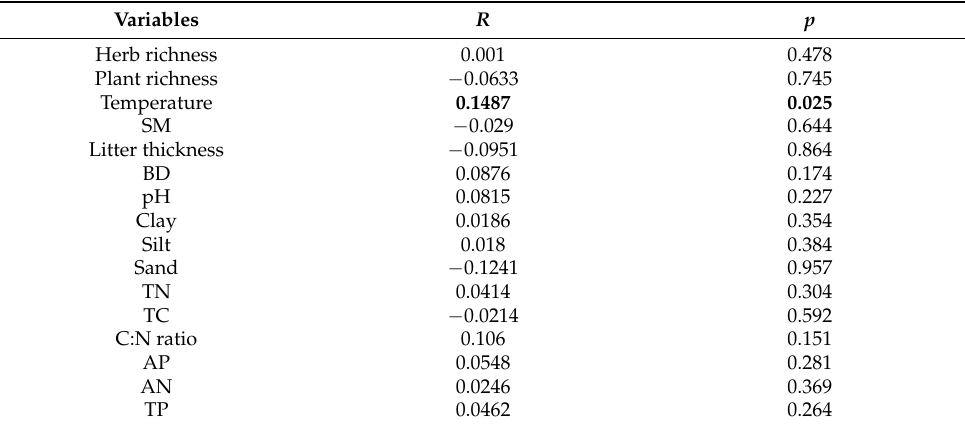
Table 3. The relationships of fungal community structure to environment variables revealed by Partial Mantel